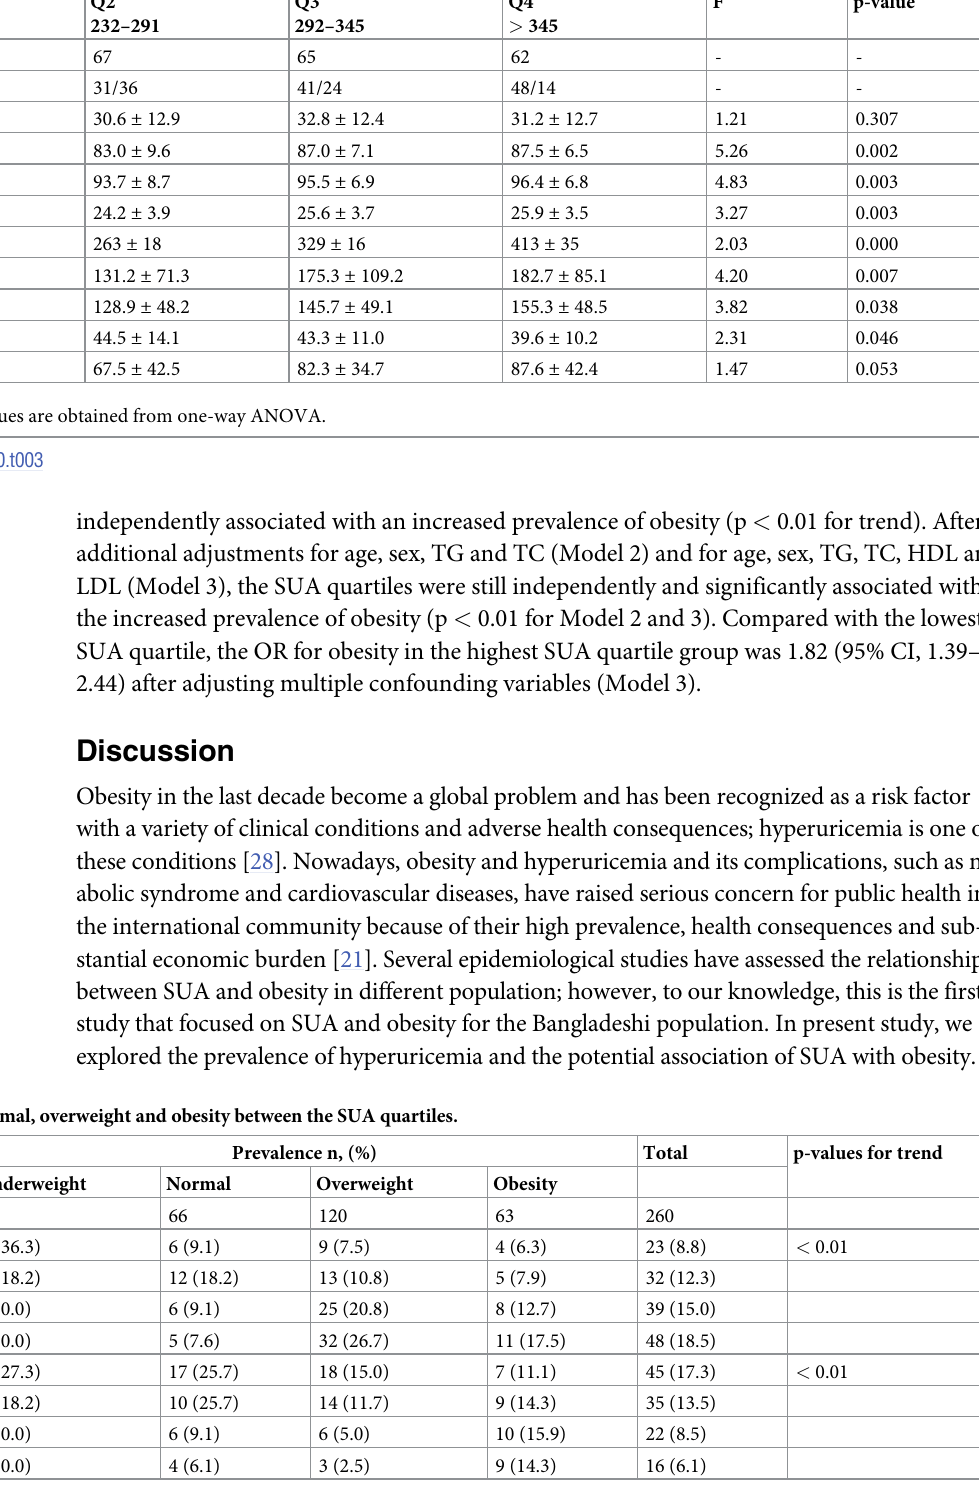
Table 3. Characteristics of the subjects according to SUA ( μ mol/L) quartiles.